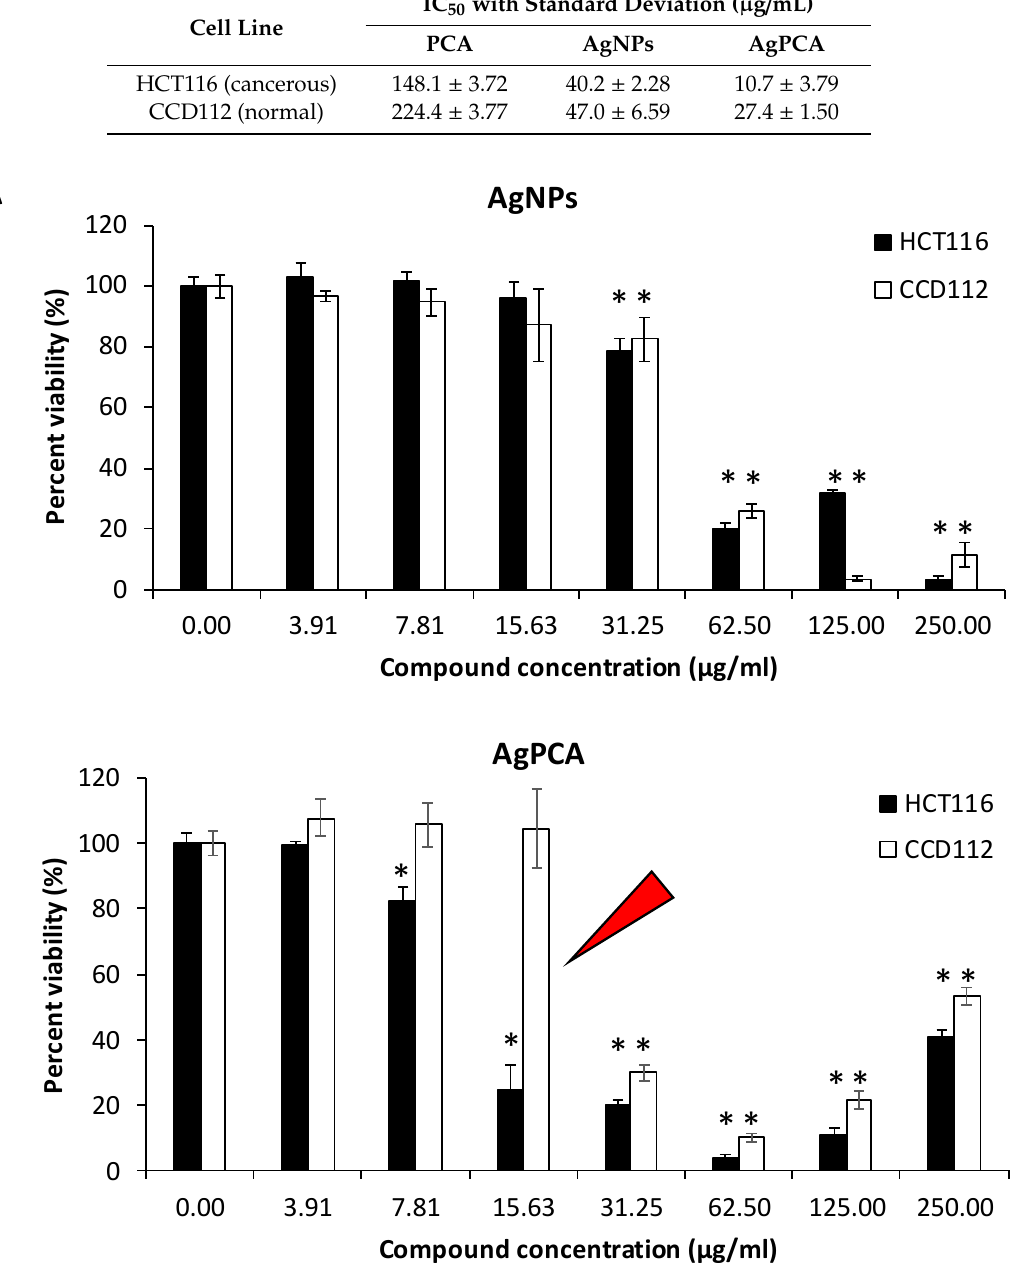
Figure 7. Cytotoxic e ff ects of nanoparticles ( A ) AgNPs and ( B ) AgPCA against colorectal cancer (HCT116) and colon normal (CCD112) cells. Red triangle shows the selectivity activity of AgPCA on HCT116, but not CCD112. Data are expressed as mean + standard deviation for triplicates within an individual experiment. Statistical significance was performed using Student’s t test. (* p < 0.05).